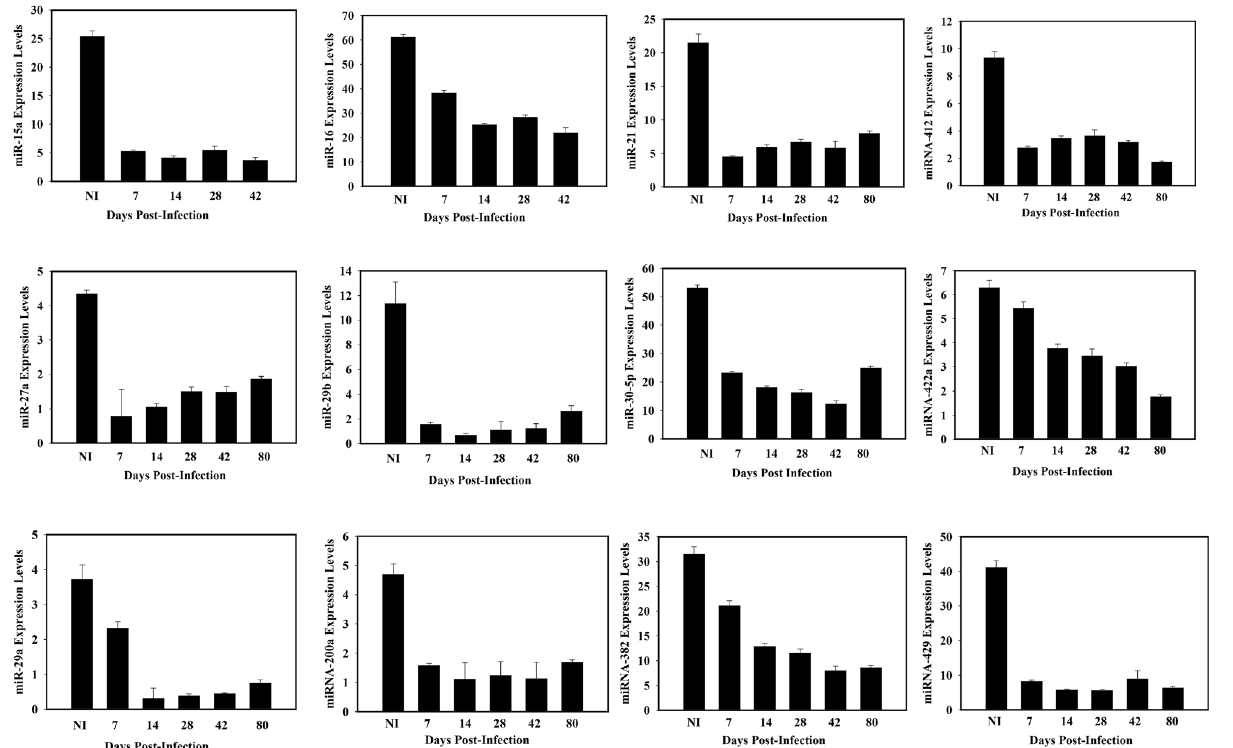
Fig 1. Chlamydial genital infection caused a sustained alteration of key miRNAs that control the functional integrity of epithelial cells (down- regulated miRNAs). Analysis of the pattern of expressed miRNAs in the oviducts of infected infertile mice and non-infected mice employed a combination of microarray and quantitative real time PCR as per Signosis ’ miRNA Array IV service (Signosis, Inc. Sunnyvale, CA), as described in the Materials and Methods section. The labeled oligonucleotide probe mixture corresponded to 540 randomly selected miRNAs which have been reported to play a role in inflammation, apoptosis and cancer by literature search [101]. Quantitative Real-Time PCR was used to validate the microarray data using miRNA-specific oligo mix. Information about miRNA target mRNA genes was obtained from several Web-accessible miRNA database searching programs, including http:// www.microrna.org, http://www.miRBase.org, http://www.targetscan.org and published reports [102]. Results presented in Table 1 (are shown as Fig 1 Down-regulated ) were derived from oviducts harvested from 1 wk through at 80 days (11.4 wk) post-infection. Experiments were repeated 4 times with at least 6 oviducts in each group. Statistically significant changes had P value from (cid:1)